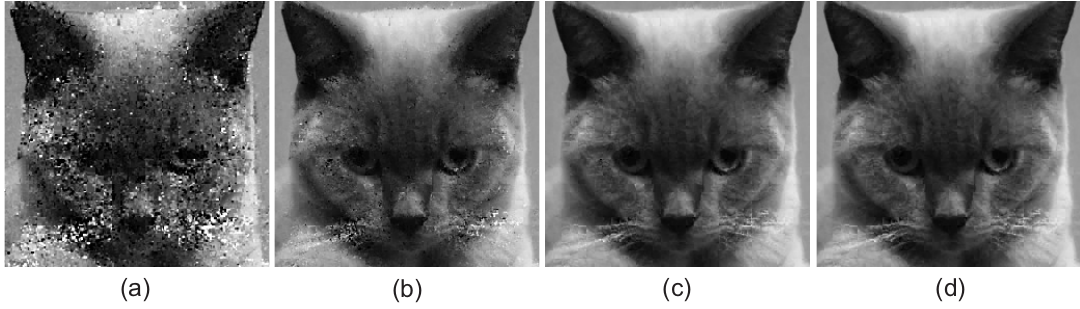
Figure 3. Cat image of size 256 × 256 encoded with 8 × 8 range block fractal and decoded under different iterations an initial image of a zero matrix: ( a ) the 3rd iteration; ( b ) the 5th iteration; ( c ) the 7th iteration; and ( d ) the 20th iteration.